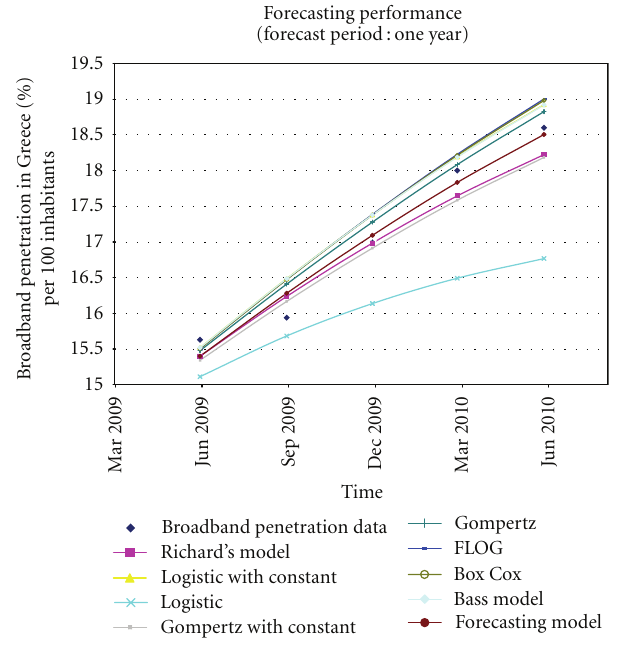
Figure 6: The performance of the models for forecast period of one year.